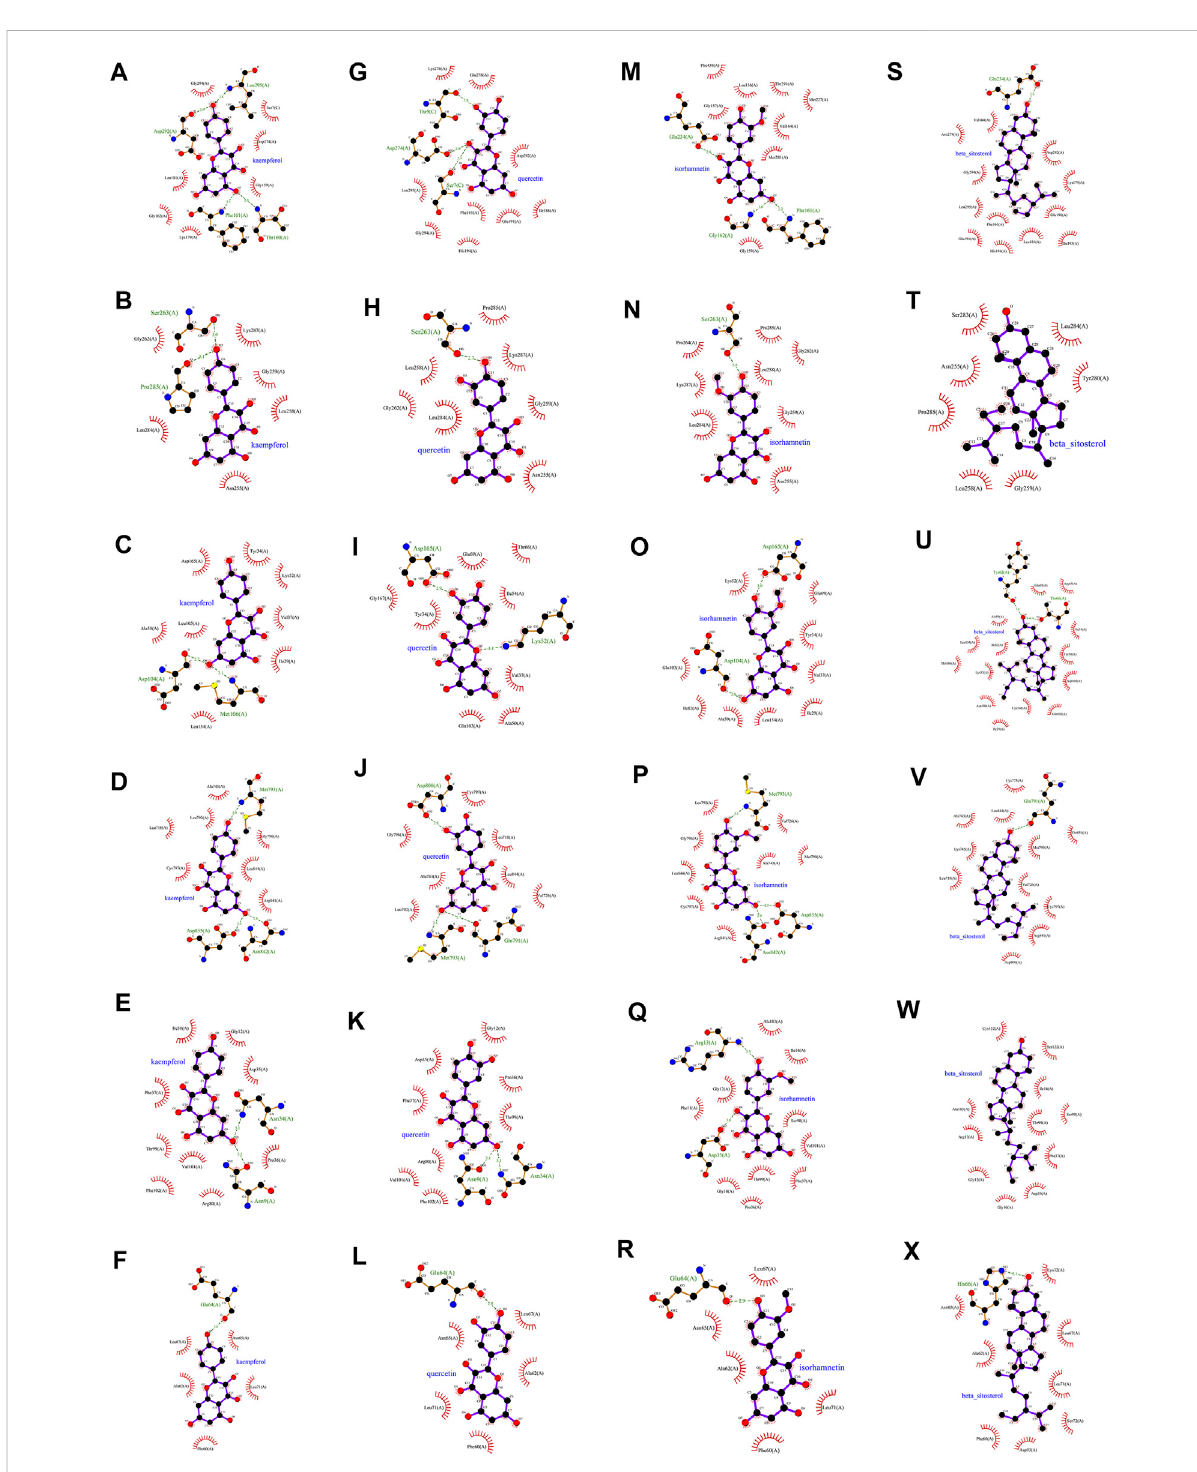
FIGURE 9 Molecular modelsofkaempferol,quercetin,isorhamnetinandbeta-sitosterolthat bindto thepredicted proteintargets,shown as 2Ddiagrams. (A) Kaempferol-AKT1, (B) kaempferol-MAPK3, (C) kaempferol-MAPK1, (D) kaempferol-EGFR, (E) kaempferol-GAPDH, (F) kaempferol-TNF, (G) quercetin-AKT1, (H) quercetin-MAPK3, (I) quercetin-MAPK1, (J) quercetin-EGFR, (K) quercetin-GAPDH, (L) quercetin-TNF. (M) isorhamnetin-AKT1, (N) isorhamnetin-MAPK3, (O) isorhamnetin-MAPK1, (P) isorhamnetin-EGFR, (Q) isorhamnetin-GAPDH, (R) isorhamnetin-TNF, (S) beta- sitosterol-AKT1, (T) beta-sitosterol-MAPK3, (U) beta-sitosterol-MAPK1, (V) beta-sitosterol-EGFR, (W) beta-sitosterol-GAPDH, (X) beta-